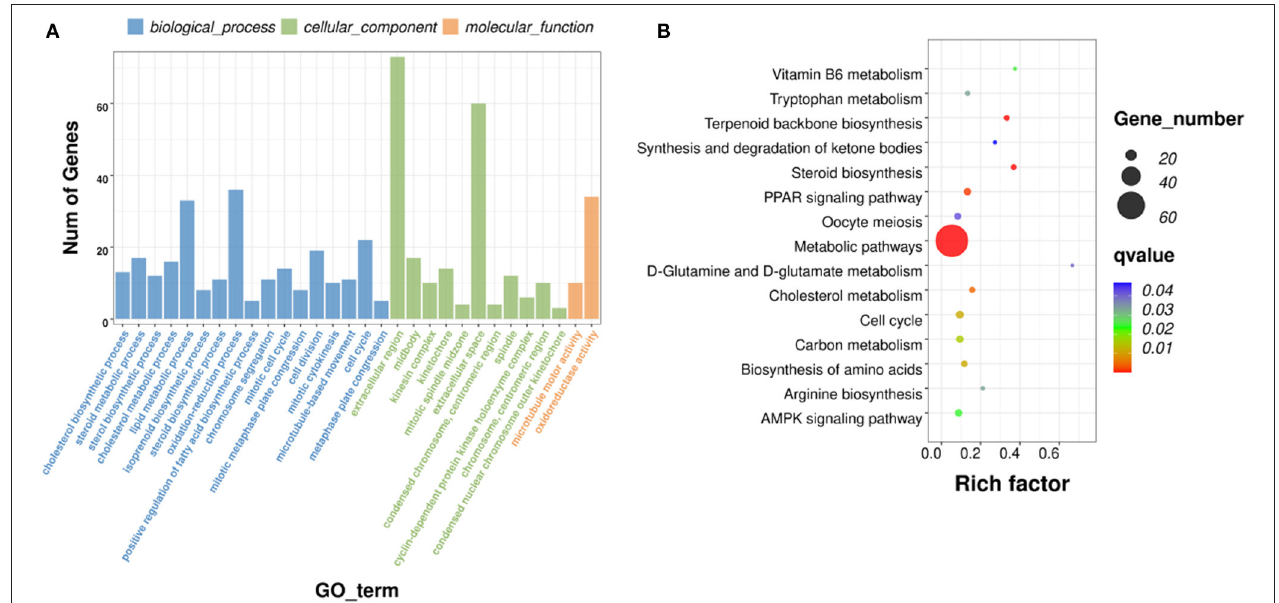
FIGURE 6 | GO and KEGG pathway analyses. (A) Histograms of GO enrichment, KEGG functional classification of DEmRNAs. (B) Significantly enriched KEGG pathways (padj < 0.05).